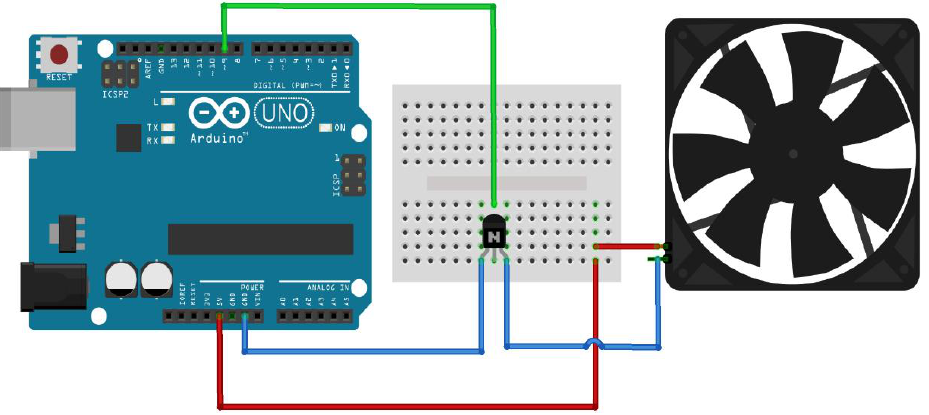
Figure 7. The control circuit for the fan speed in the smart home.